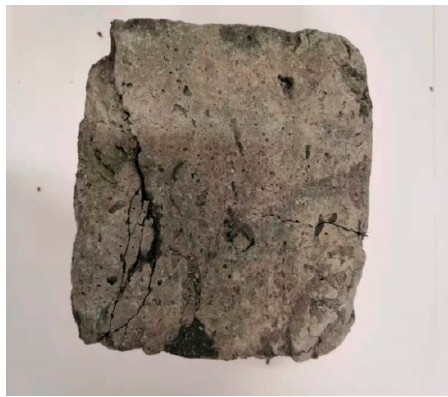
Figure 3. Fracture specimen. Table 4. Compressive strength of the